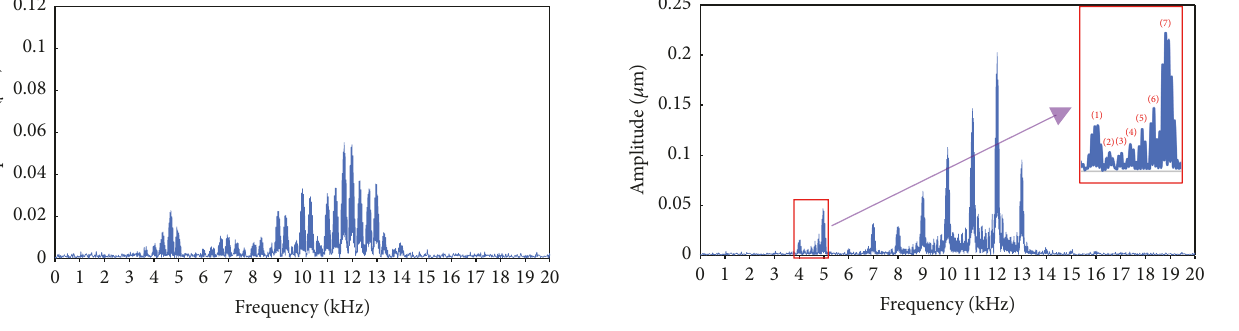
Figure 41: Spectrum of the residual signal obtained for the first scenario (two nonconsecutive cracked teeth with 30% CLP).